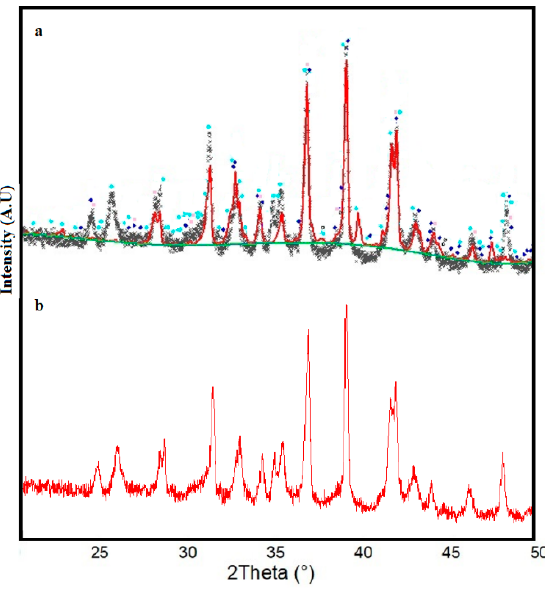
Figure 13. X-ray diffraction patterns: (a) Mixture 3 at 1200 °C with the annealing process at 930 °C and 1100 °C for 2 h; (b) Mixture 3 at only 1200 °C.